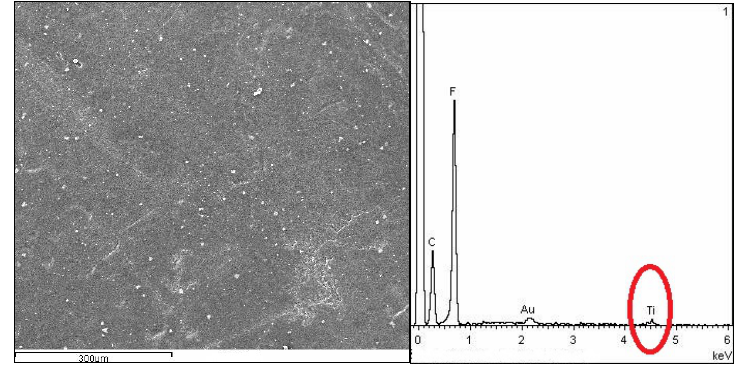
Figure 3. The elements and their contents on the PVDF-PVP-TiO 2 membrane determined by EDS.